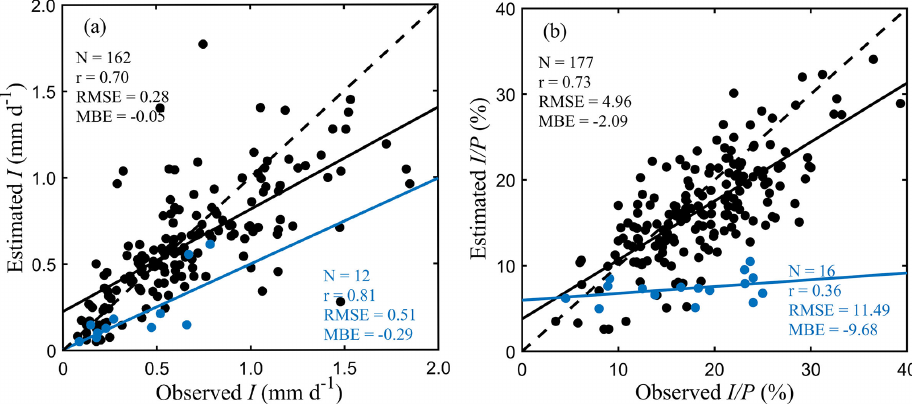
Figure 3. Field validation. (a) I (in mmd − 1 ) and (b) I/P (in %). Black and blue scatters represent the stand-scale simulations of tall vegetation and short vegetation,